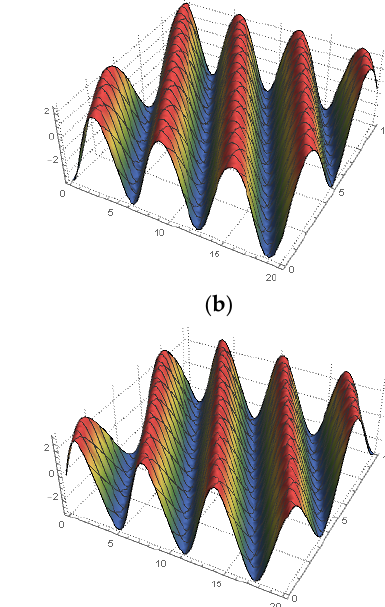
( d ) Figure 5. The 3D plots of the real and imaginary parts of 𝐹𝐹 7 ( 𝑥𝑥 , 𝑑𝑑 ) and 𝐺𝐺 7 ( 𝑥𝑥 , 𝑑𝑑 ) with the parameters 𝑟𝑟 1 = 𝑟𝑟 2 = 0.3, 𝑘𝑘 1 = 𝑘𝑘 2 = 1, 𝑞𝑞 0 = 0.9, 𝑝𝑝 3 = 4, 𝑞𝑞 1 = 5/7, 𝜌𝜌 = 1 and 𝜏𝜏 = 0 for the fractional order 𝛼𝛼 = 0.65 : ( a ) 𝑅𝑅𝑒𝑒 [ 𝐹𝐹 7 ( 𝑥𝑥 , 𝑑𝑑 )] , ( b ) 𝑅𝑅𝑒𝑒 [ 𝐺𝐺 7 ( 𝑥𝑥 , 𝑑𝑑 )], ( c ) 𝐼𝐼𝐼𝐼 [ 𝐹𝐹 7 ( 𝑥𝑥 , 𝑑𝑑 )] and ( d ) 𝐼𝐼𝐼𝐼 [ 𝐺𝐺 7 ( 𝑥𝑥 , 𝑑𝑑 )]. Family III: When 𝑝𝑝 3 = 𝑞𝑞 3 = 0 , let 𝑞𝑞 0 , 𝑝𝑝 2 , 𝑞𝑞 1 , 𝑟𝑟 1 and 𝑟𝑟 2 be arbitrary constants. Then, we get the following cases for 𝑝𝑝 0 , 𝑝𝑝 1 and 𝑞𝑞 2 : Case 1: